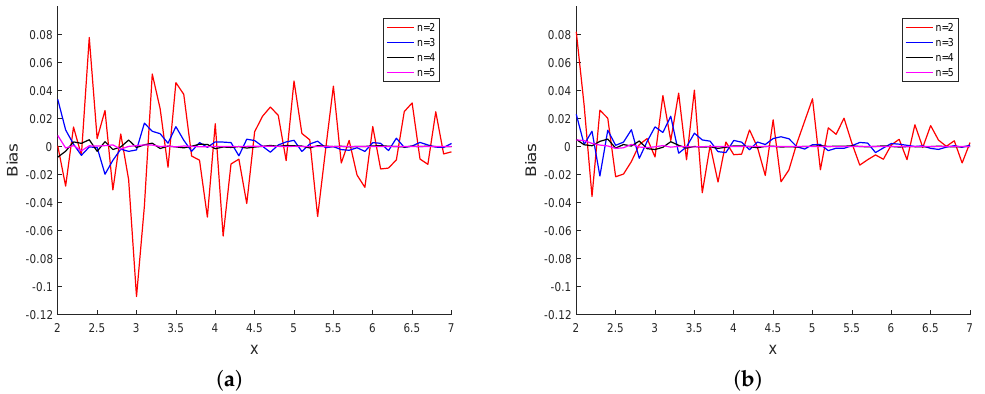
Figure 3. ( a ) Sample bias vs. x using 10 scalar measurements and ( b ) sample bias vs. x using 20 scalar measurements.